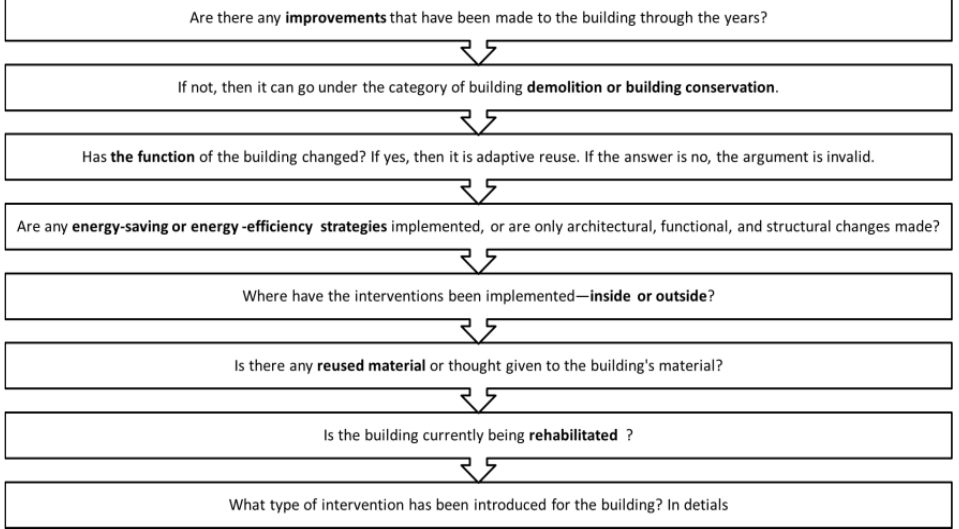
Figure 9. Percentages of selected adapted buildings according to their grade. The architectural significance of a building was evaluated according to the following points: •